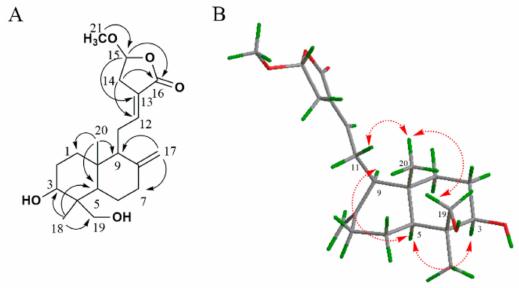
Figure 3. Key HMBC correlations ( A ) and key NOESY correlations ( B ) of AP-4